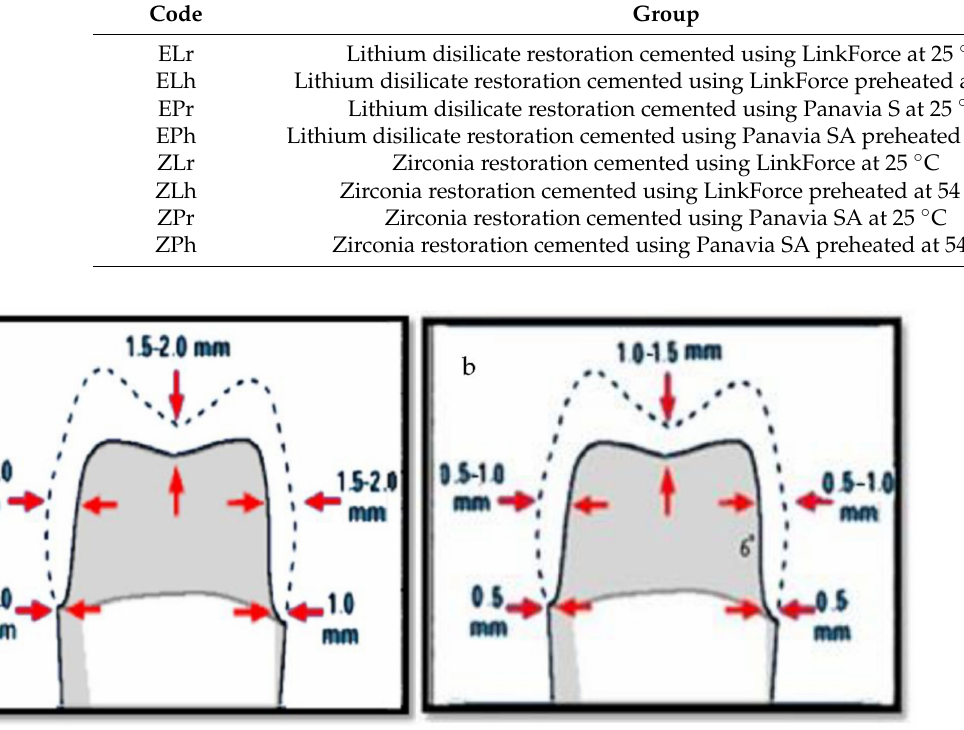
Figure 2. Illustration of tooth preparation to receive: ( a ) lithium disilicate restoration; ( b ) zirconia restoration. Fabrication of lithium disilicate restorations ( n = 40): Each tooth was sprayed with anti-reflection scan powder spray (Telescan white, DFS Diamon GmbH, Riedenburg, The Netherlands) and scanned (ceramill Map 400, Amann Girrbach GmbH, Koblach, Austria), then the restorations were designed (Ceramill Mind, Amann Girrbach GmbH,